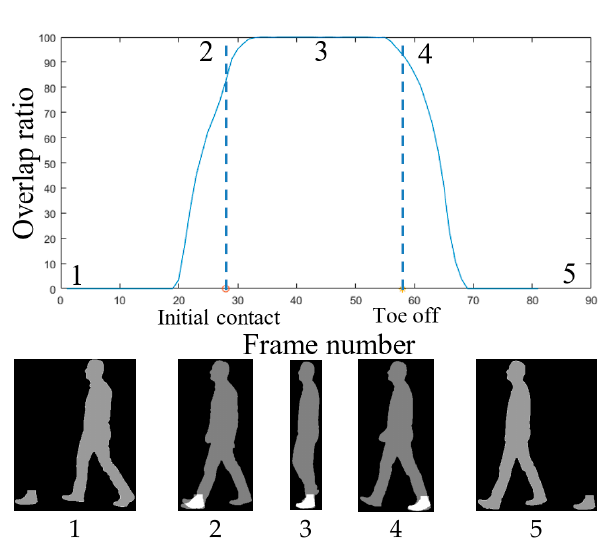
Figure 4. Plot representing the foot flat overlap ratio ( top ) and the corresponding silhouettes ( bottom ).